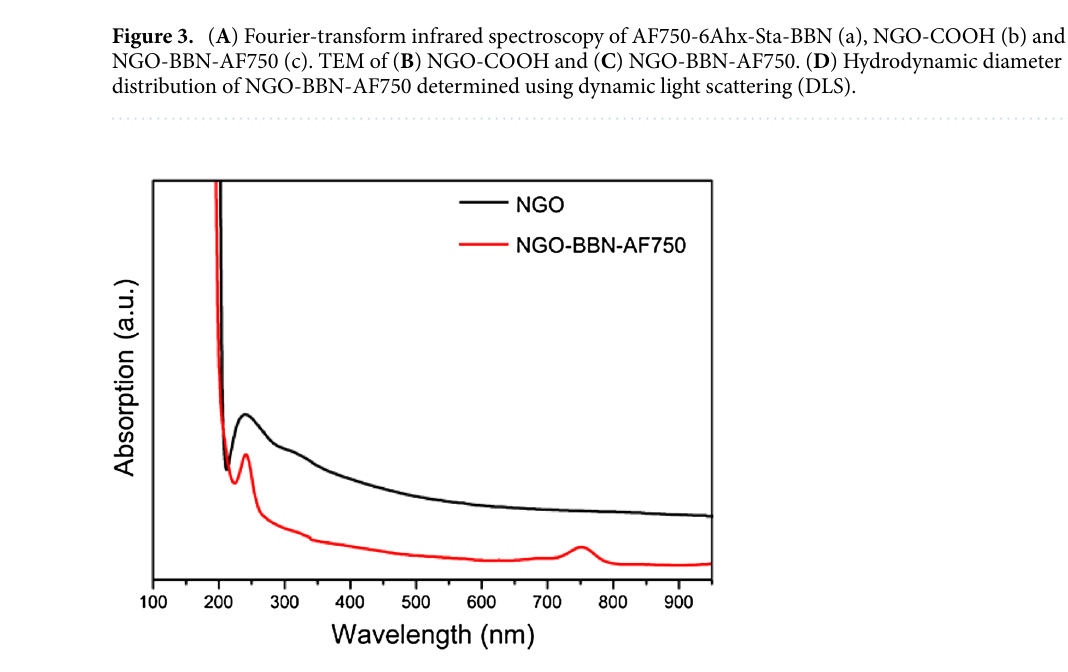
Figure 4. UV–Vis spectra of NGO and NGO-BBN-AF750